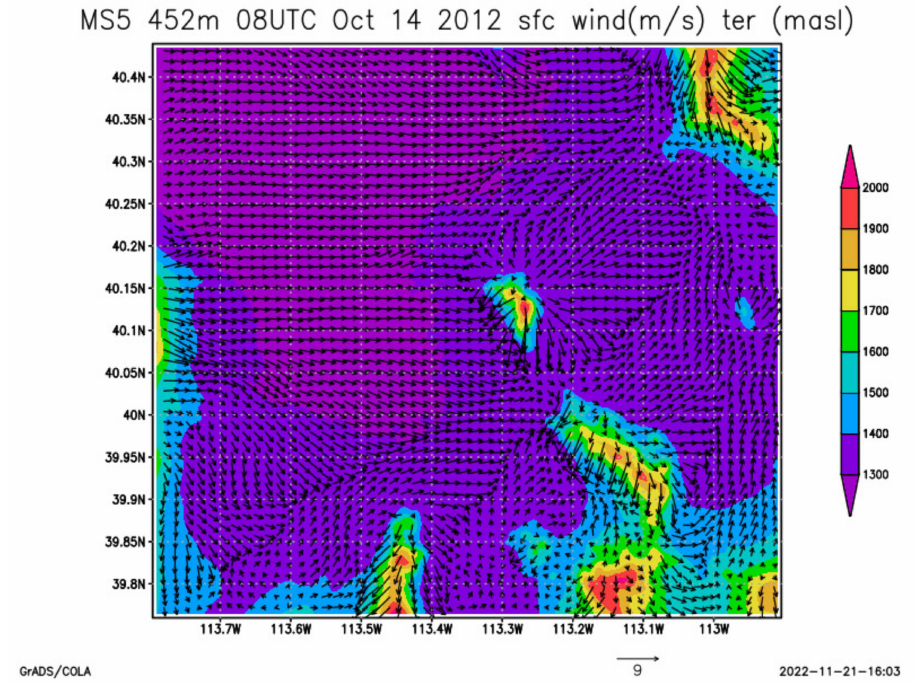
Figure 12. Model MS5 surface 10 m AGL wind vectors (m/s) for nest 4 (0.452 km), plotted over the model terrain (m ASL), valid at 0800 UTC